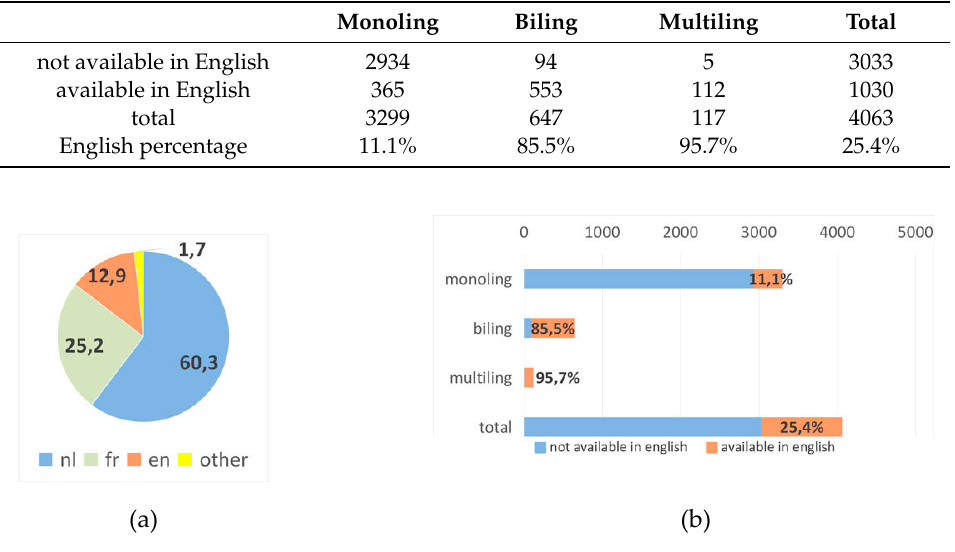
Figure A2. Visualization of the results for domain be. ( a ) Primary languages pie chart and ( b ) English language availability bar chart.